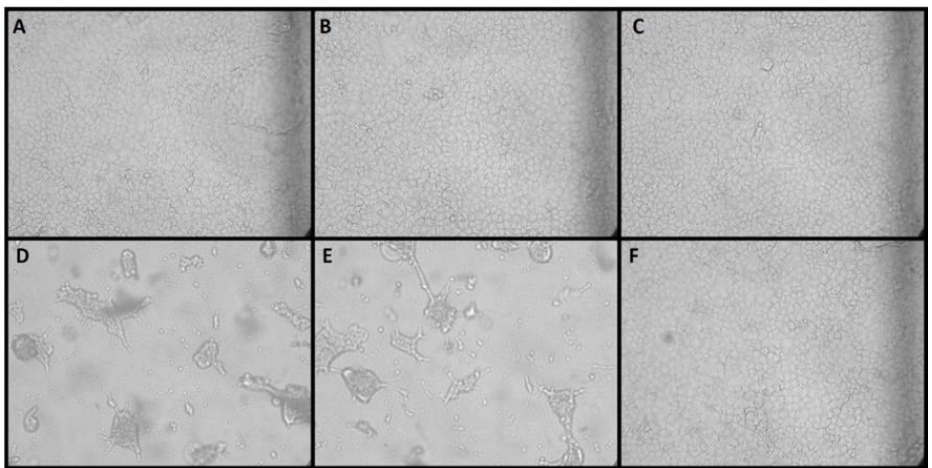
Figure 2. Inactivation of NiV by Formalin. NiV was incubated with either 10% neutral buffered formalin ( A – C ) or TCM ( D , E ) and 10% formalin was incubated with TCM ( F ). All incubation was for 24 h. After incubation, the samples were washed twice by ultracentrifugation and then added to T75 tissue culture flasks. Images show the cell monolayer after passage into T150 flasks. Infection (as seen in D , E ) indicated that the virus was not inactivated. Intact monolayers ( A – C ) suggest that all viable virus has been inactivated.